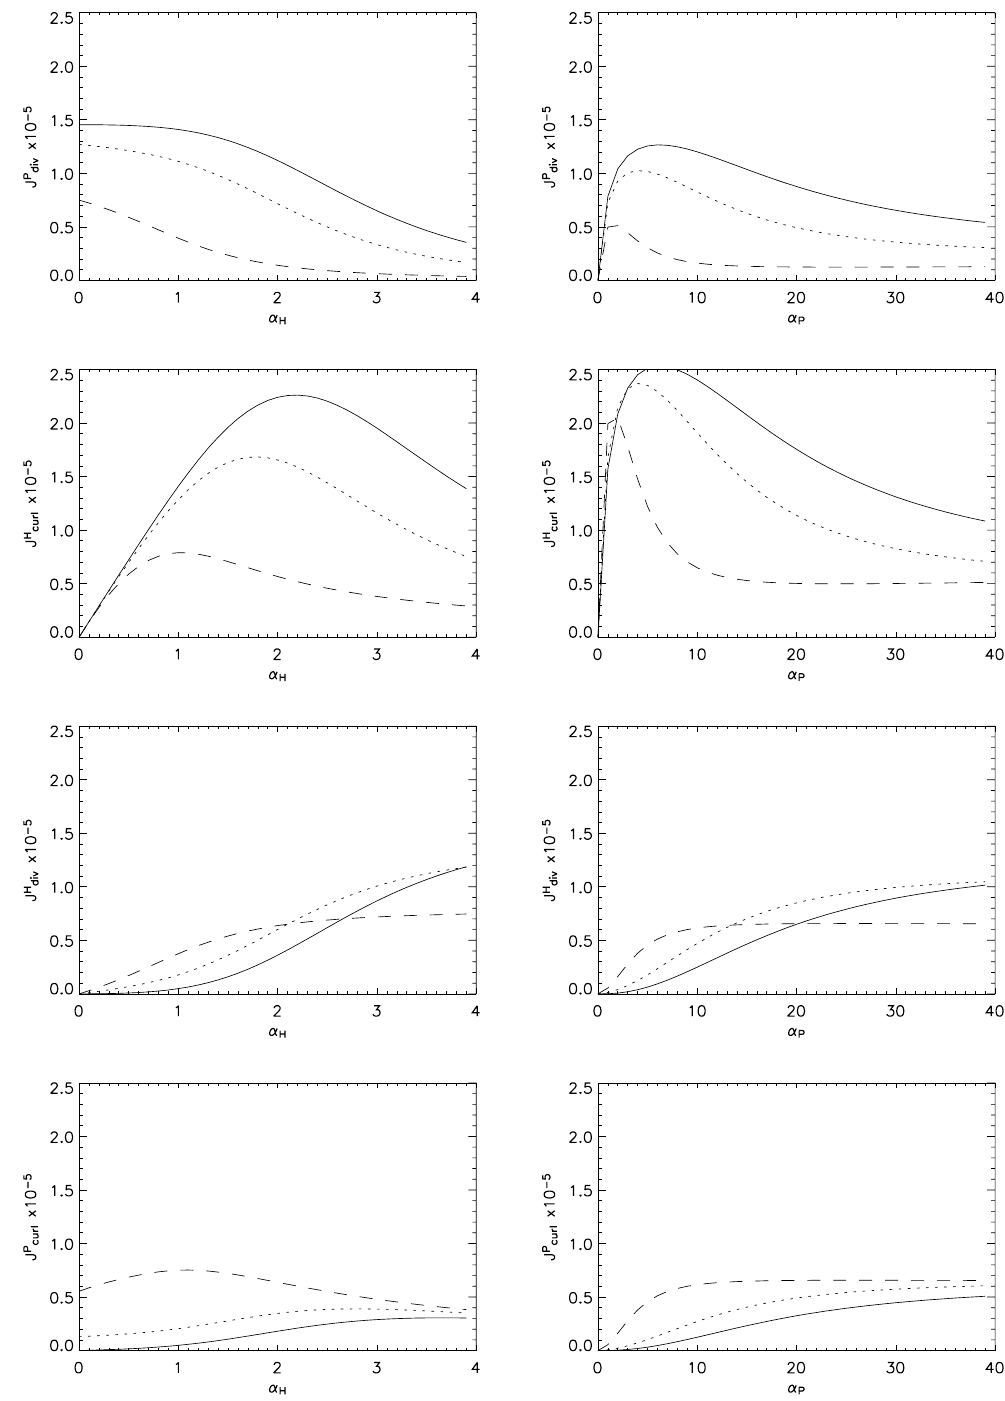
Fig. 7. The magnitude of the ionospheric current densities for the inductive effect where V a = 1 × 10 6 ms − 1 , k x = 0, k y =1/d for d=100km and f=40mHz. The variation with α P has α H = 2 and the variation with α H has 6 P = 10S. The dip angle of B 0 is 90 ◦ (solid), 60 ◦ (dotted) and 30 ◦ (dashed)